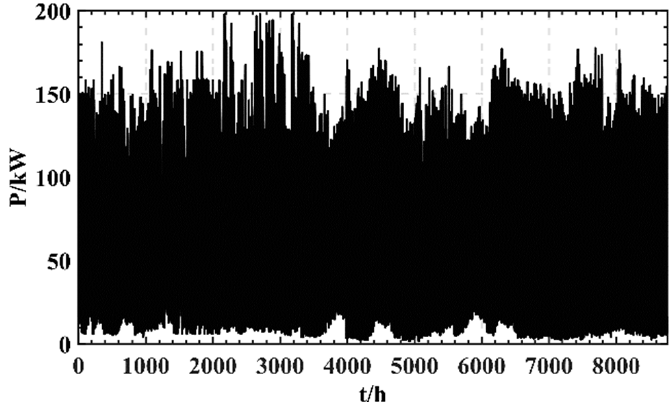
Figure 7. Annual distribution of load power demand.